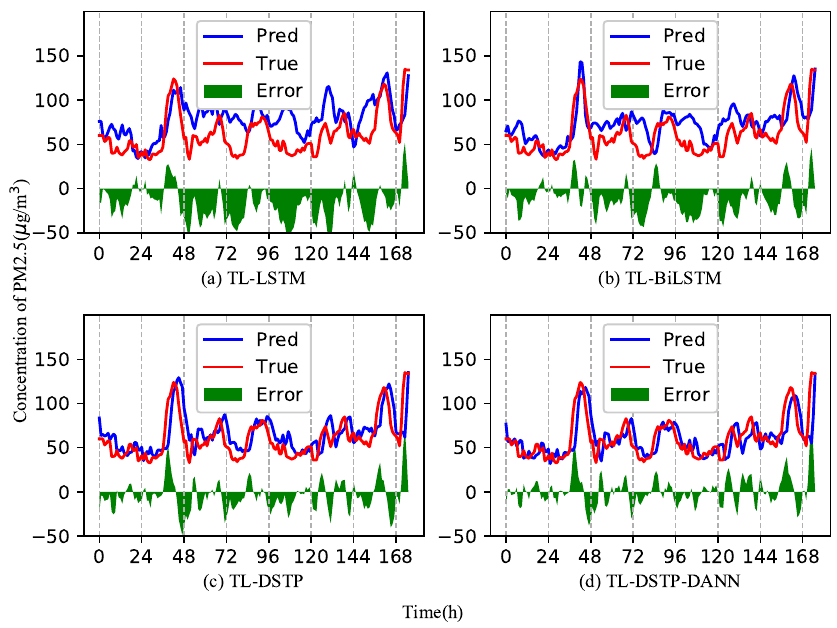
Figure 4. Performance comparison of four models for predicting PM2.5 concentration at Tianjin site.